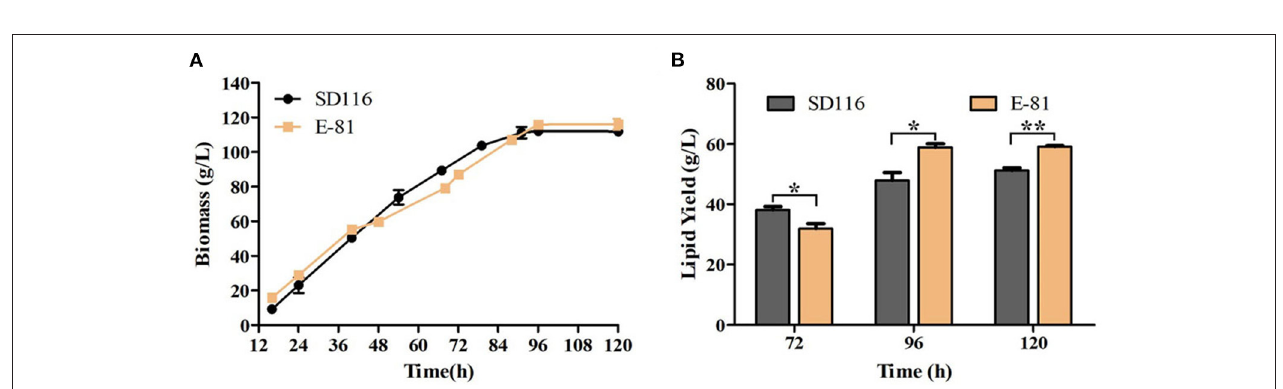
FIGURE 5 | Fed-batch fermentation of SD116 and E-81 strains. (A) Growth curve; (B) total lipid yield. ** P < 0.01 and * P < 0.05.